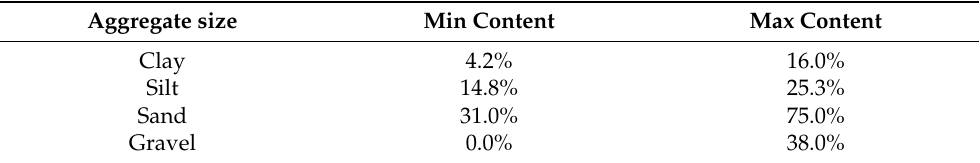
Table 5. The limits of the ranges of content for each size of aggregates.